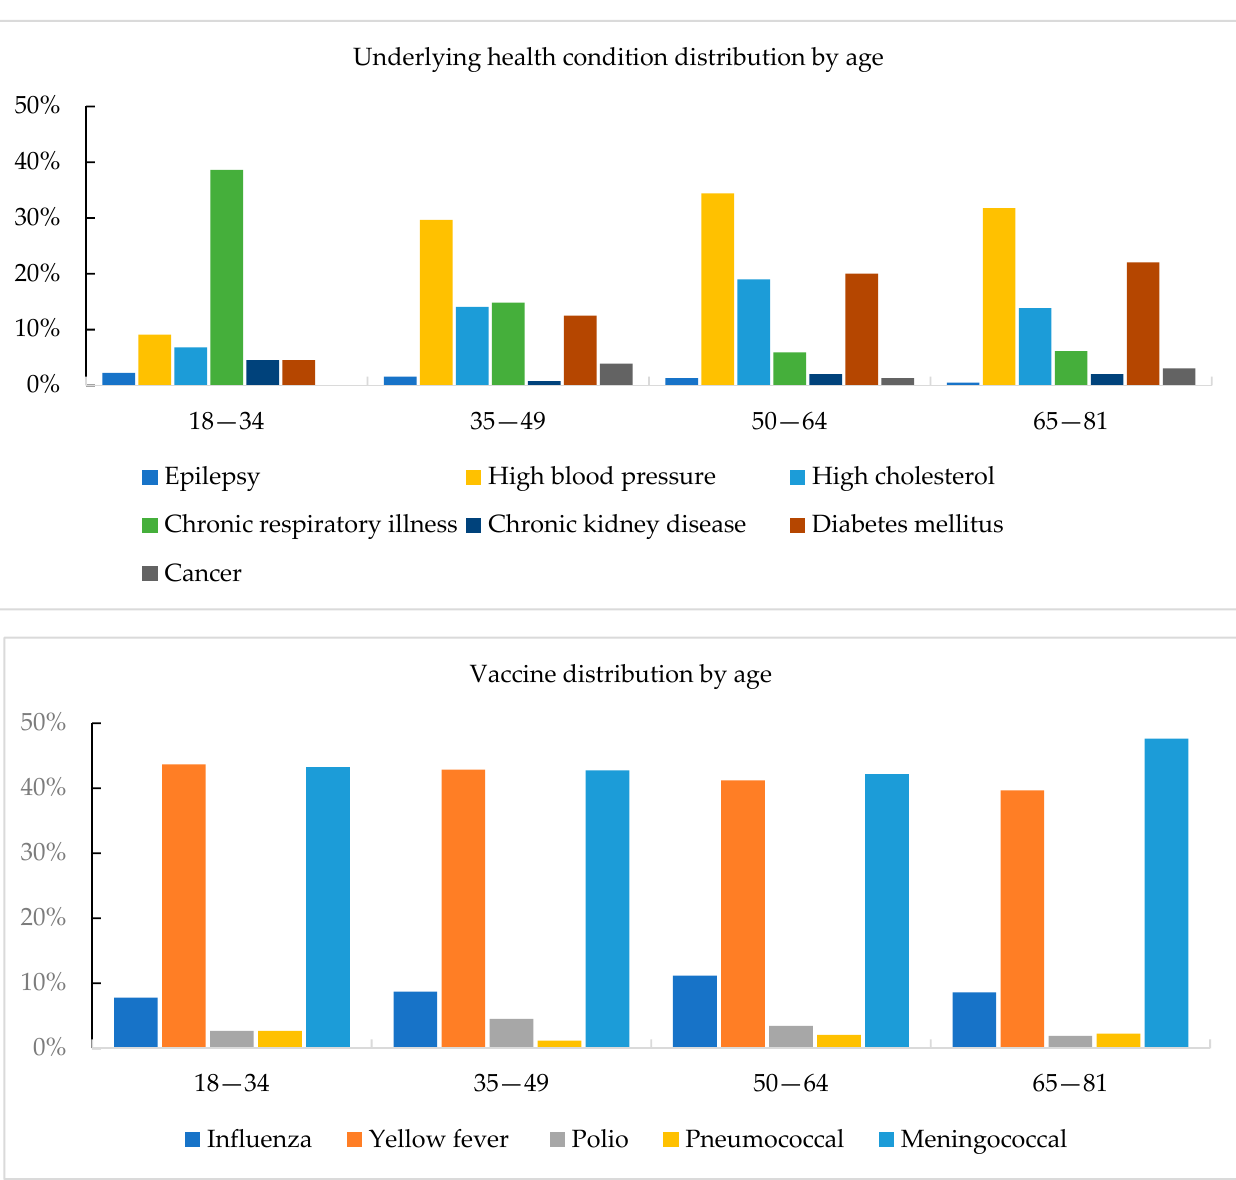
Figure 2. Vaccinations and underlying health conditions distrubtion by age groups among the study population. Table 2. Vaccination and underlying health conditions among enrolled participants.